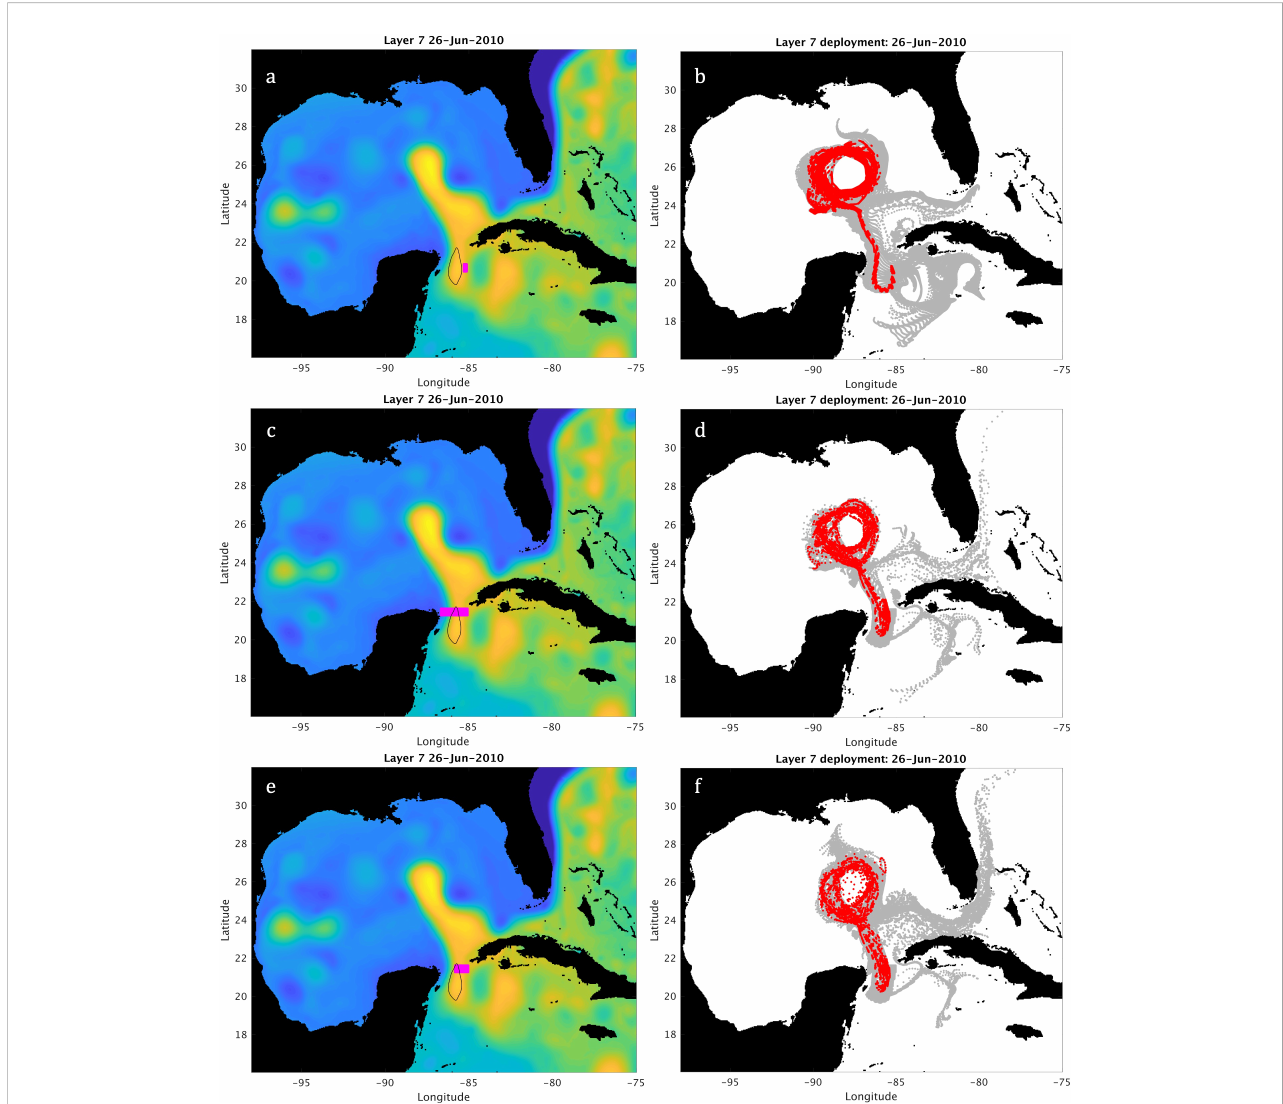
FIGURE 10 (A, C, E) Snapshots of seeding locations of Lagrangian particles (magenta boxes) and initial detection location of Caribbean anticyclone (black contour) superimposed on SSH. (B, D, F) Particle locations for each of the three particles experiments in panel (A, C, E) , respectively. The red colors represent particles that were traced inside the LCE contour at the end of each 45-day experiment and the gray colors mark particles that were traced outside the LCE